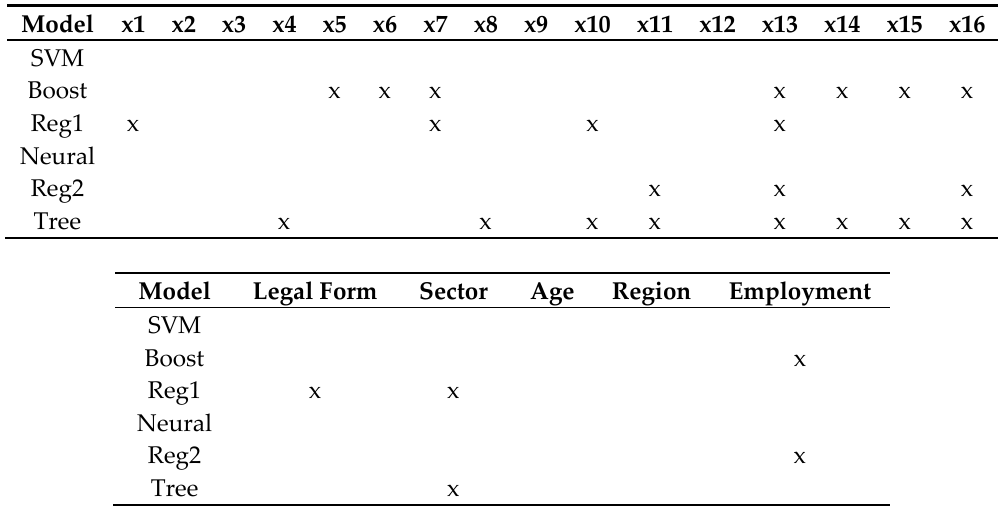
Table 9. Financial ratios and non-financial factors—significance in different models.